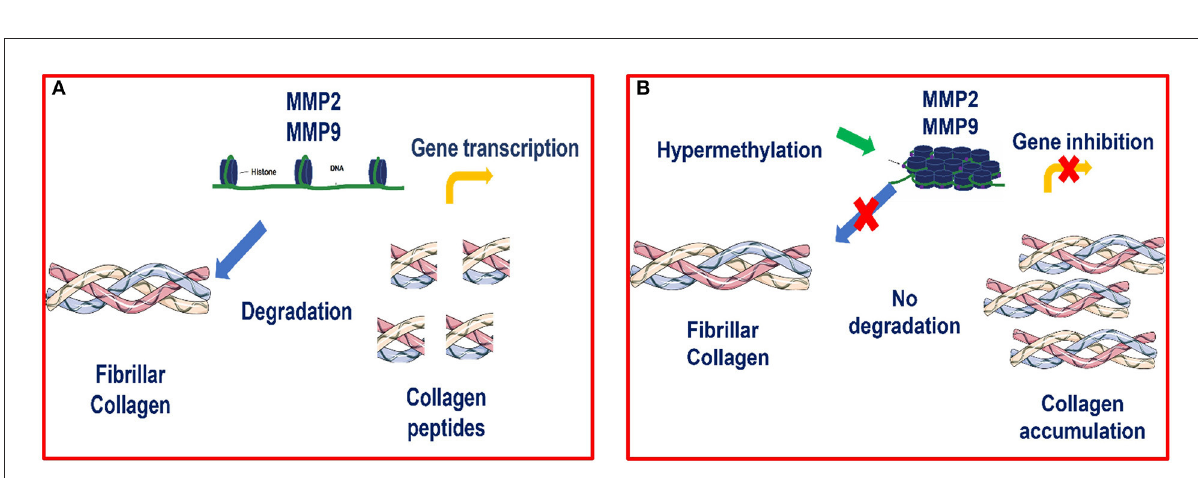
FIGURE8 (A) Transcription of MMP2 and MMP9 genes is possible when there is no hypermethylation of these genes, as chromatin is accessible and thus allows transcriptional factors to bind to the promoter region and activate the transcription process (B) Epigenetic modulation of MMP2